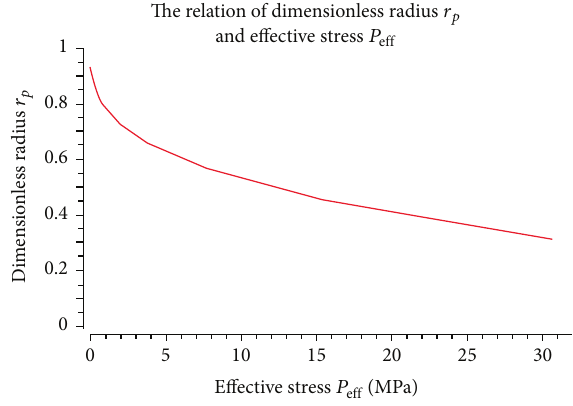
Figure 9: Star-shaped [1.0 (60%) + 0.1 (20%) + 0.05 (10%) + 0.01 (10%)].